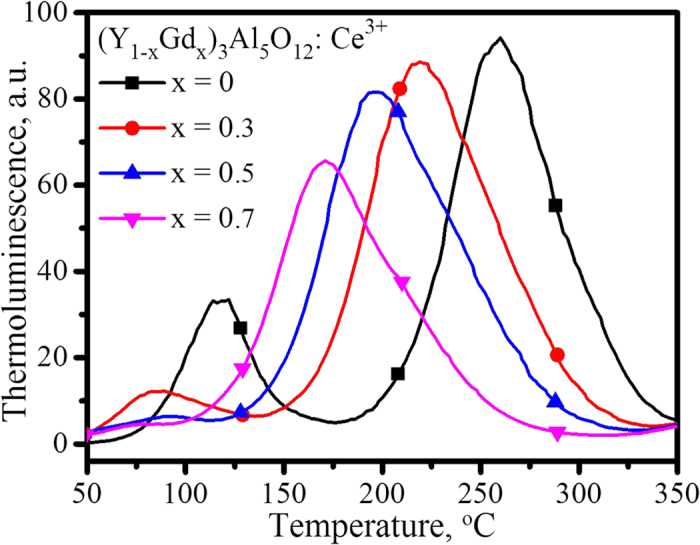
Thermally stimulated luminescence of (Y1−xGdx)2.94Al5O12: 0.06Ce3+.